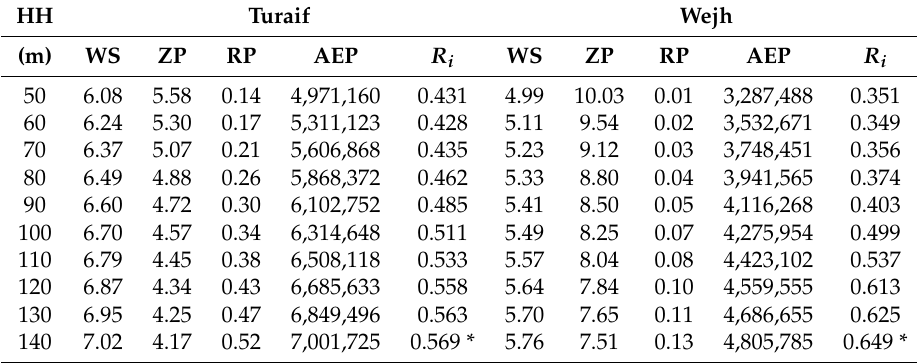
Table A8. TOPSIS analysis for turbine Gamesa G97-2.0 MW. The best choice for each site is marked with an asterisk.